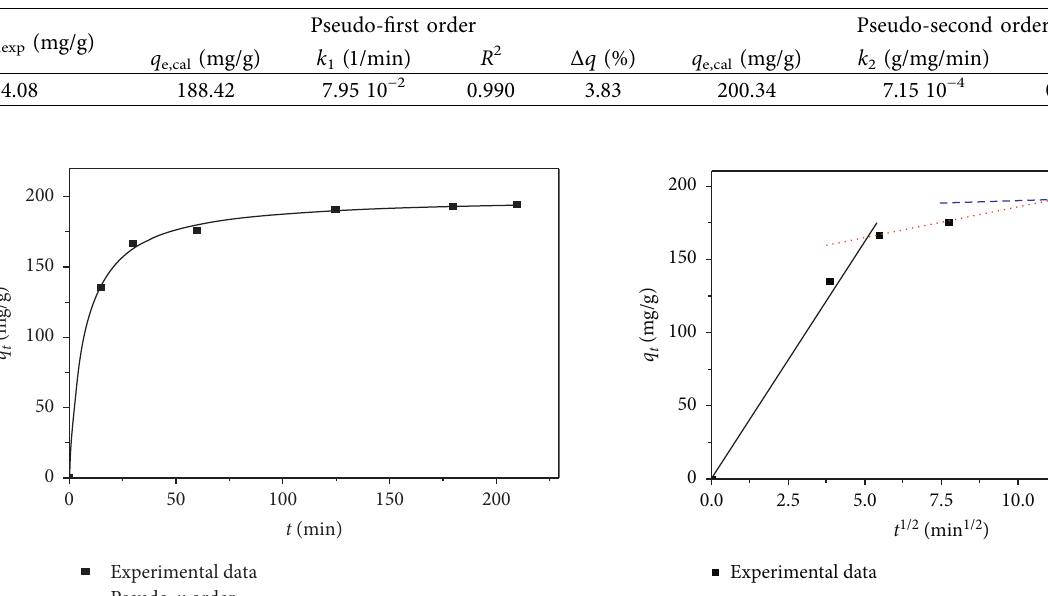
� 100mg/L; adsorbent dose � 0.2g/L; pH ∼ 7; T � 20 ° C). 0